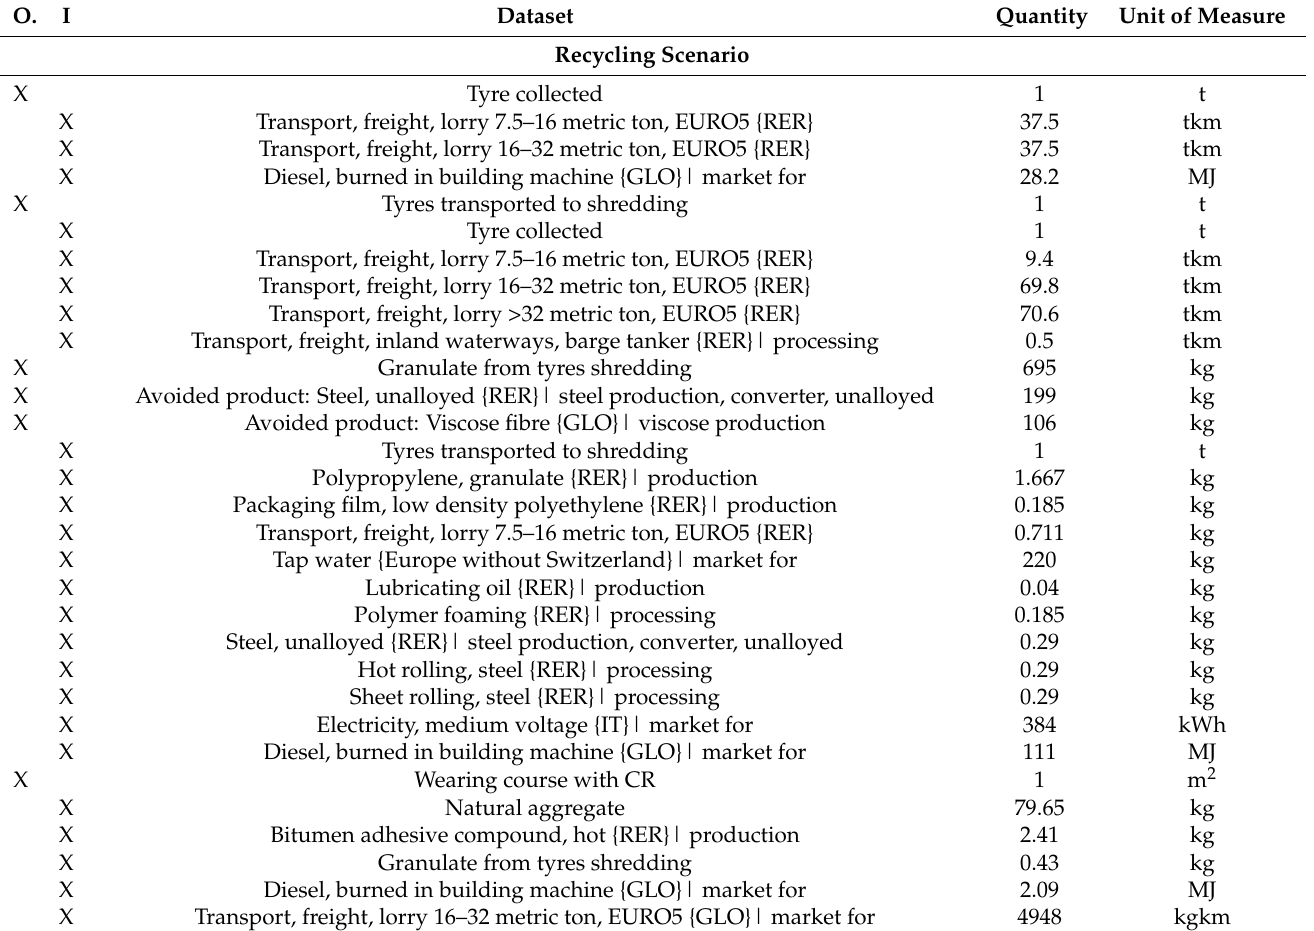
Table 1. Inventory for the two analysed